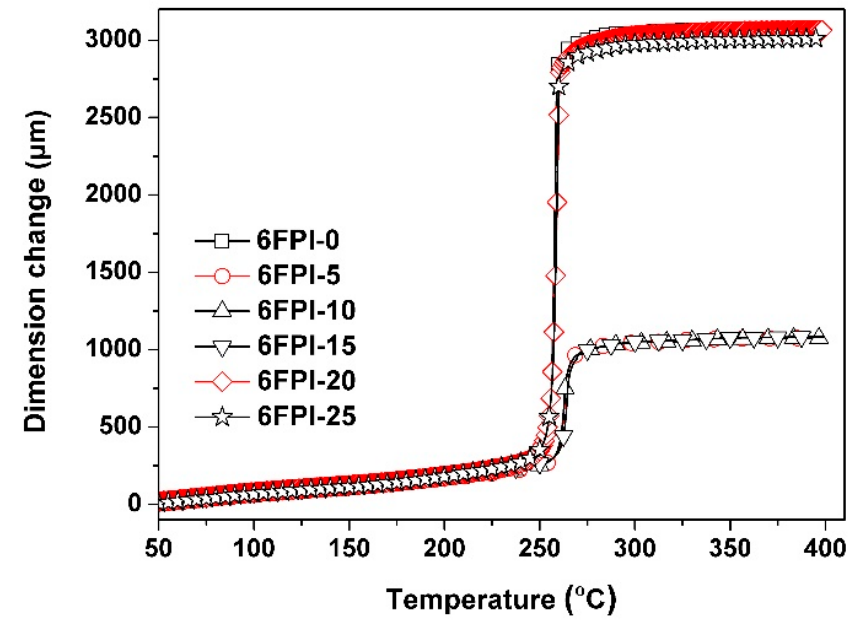
Figure 13. TMA curves 6FPI/POSS composite films at a heating rate of 10 °C/min under nitrogen flow.